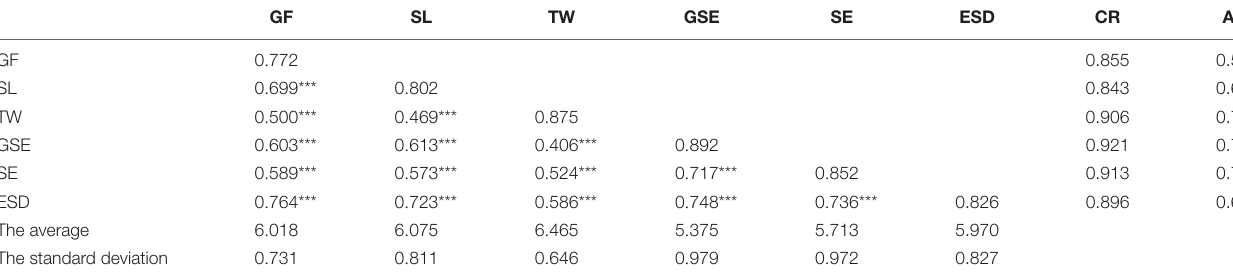
TABLE 3 | Descriptive statistics and correlation coefficients of each variable ( N = 177).